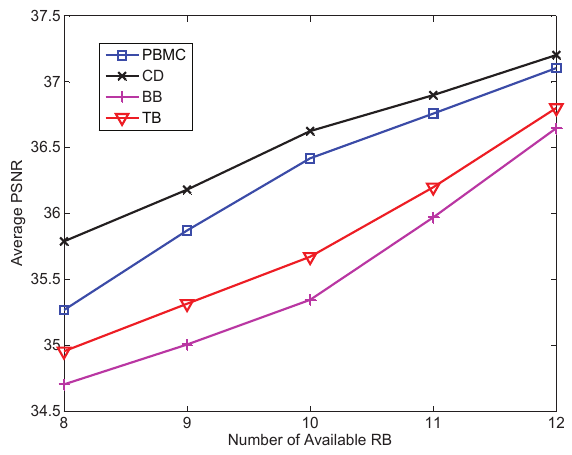
Figure 6: Average Interruption Duration under each adaptation scheme when RB number changes